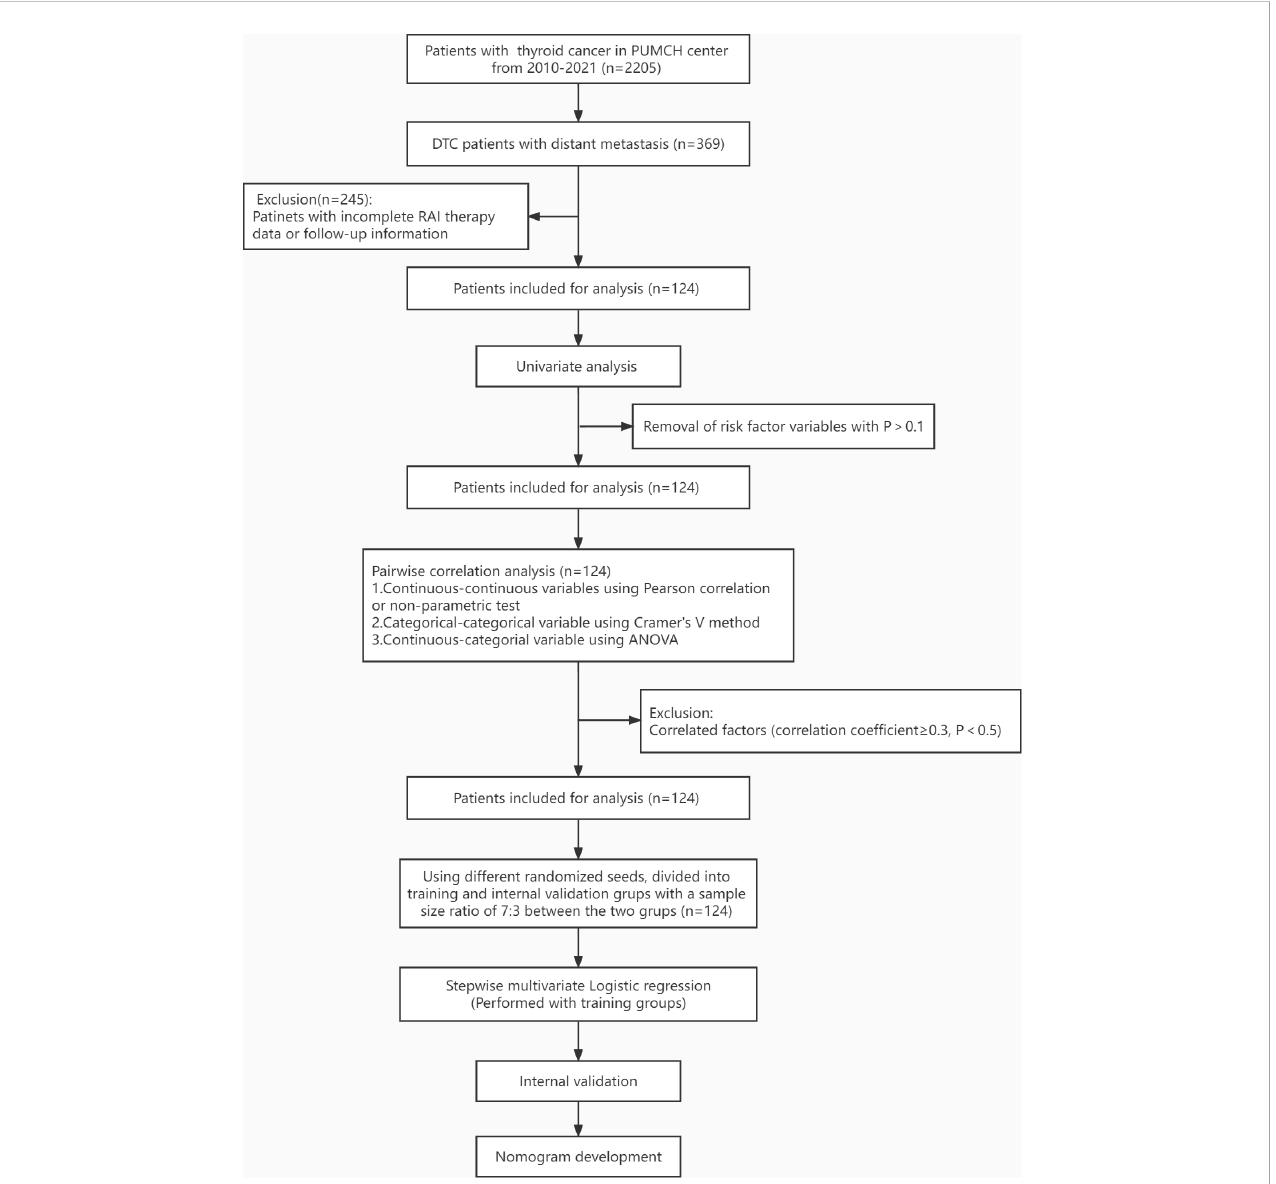
FIGURE 1 Work fl ow for patient selection and development of the nomogram model to predict RAIR among DM-DTC patients. PUMCH, Peking Union Medical College Hospital; RAIR, radioiodine refractory; DM, distant metastases; DTC, differentiated thyroid